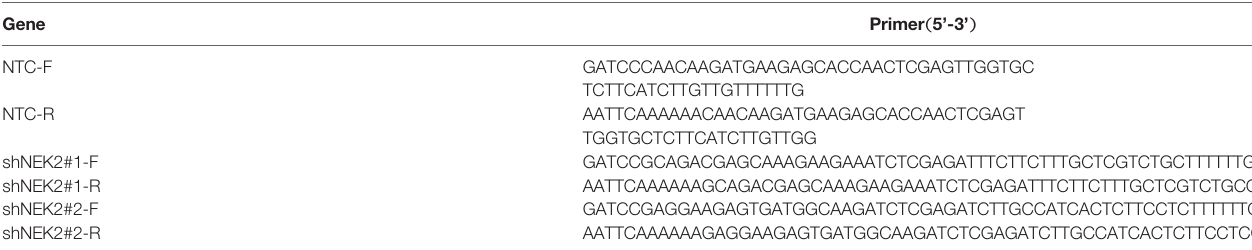
TABLE 1 | The hairpin target sequences of non-target control (NTC) and